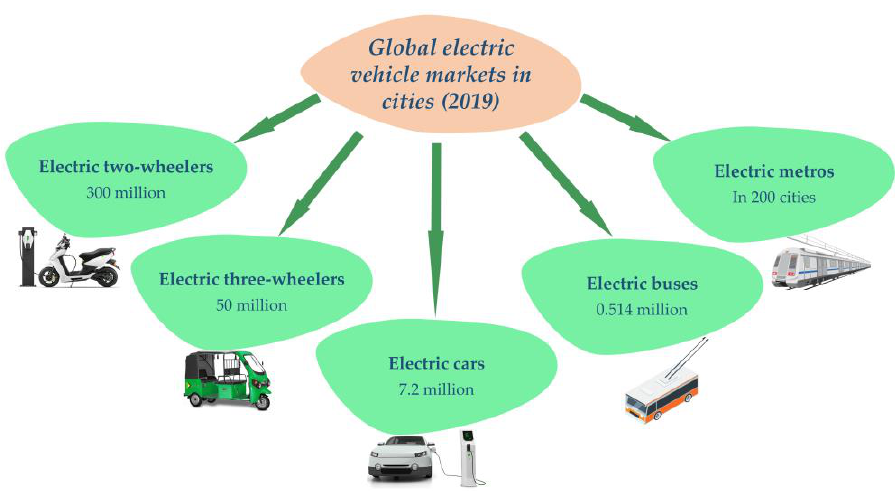
Figure 6. Global electric vehicle markets in cities [50].